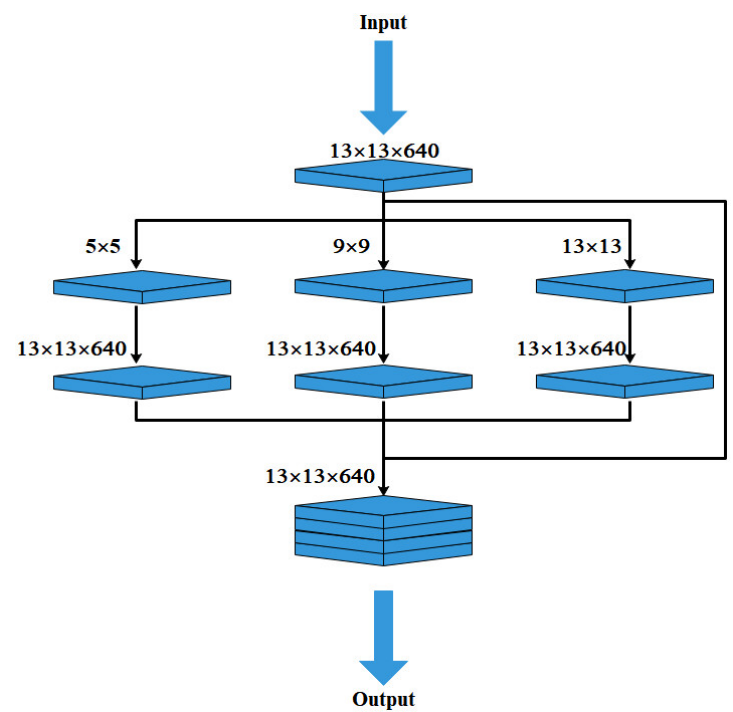
Figure 5. SPP structure.